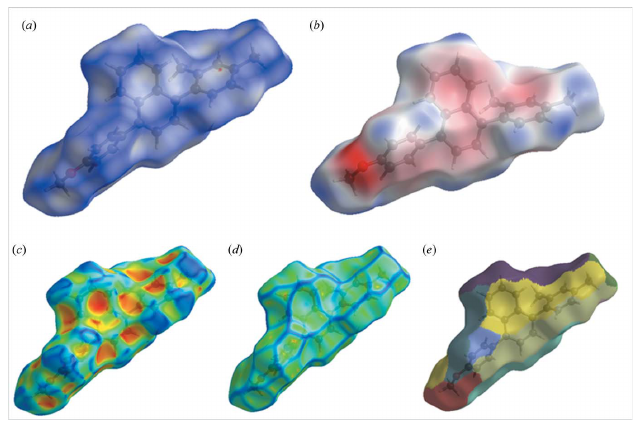
Figure 2 The crystal packing of the title compound, viewed along the b axis. The C—H (cid:2)(cid:2)(cid:2) (cid:2) interactions (see Table 1) are shown as dashed lines, and only the H atom H25 C (grey ball) has been included.